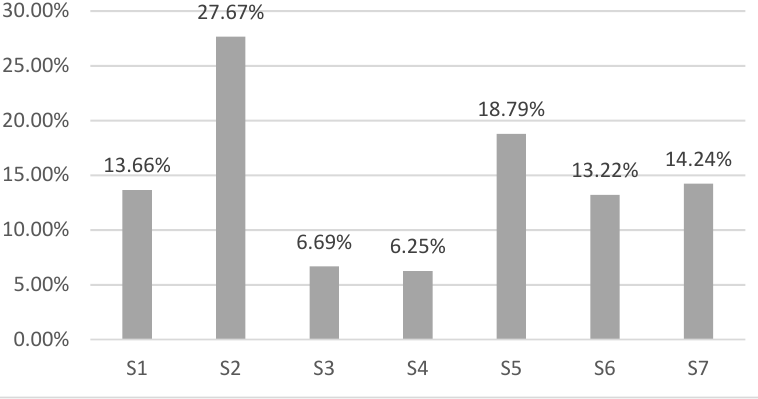
Figure 8. Water absorption coefficient of 7 samples. Table 3. Water absorption capacity (WAC, weight per weight [wt./wt.]), imbibition capacity (IC,